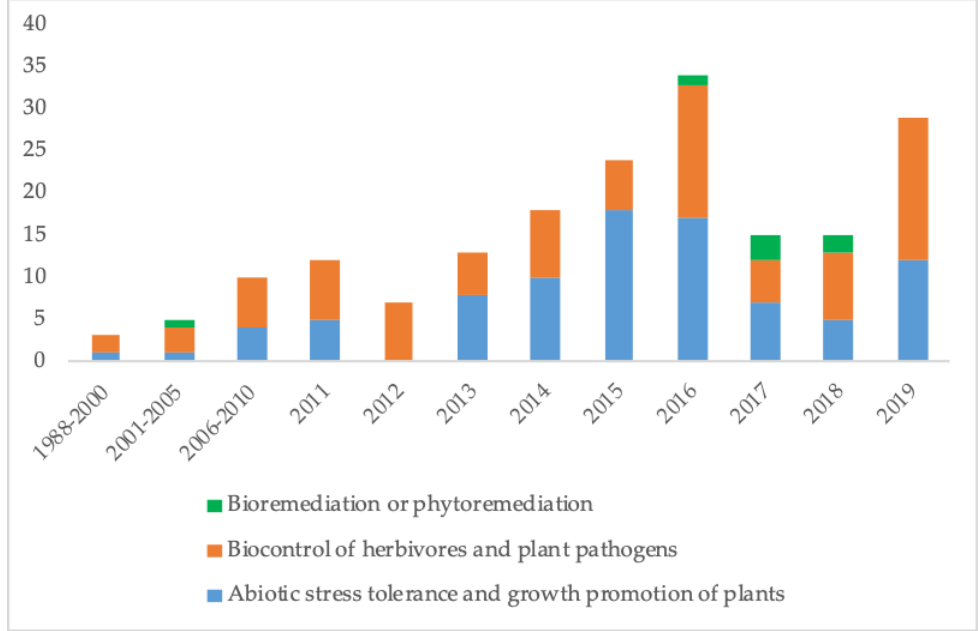
Figure 3. Patents of endophytic fungi for agricultural purposes and bio / phytoremediation registered from 1988 to 2019.